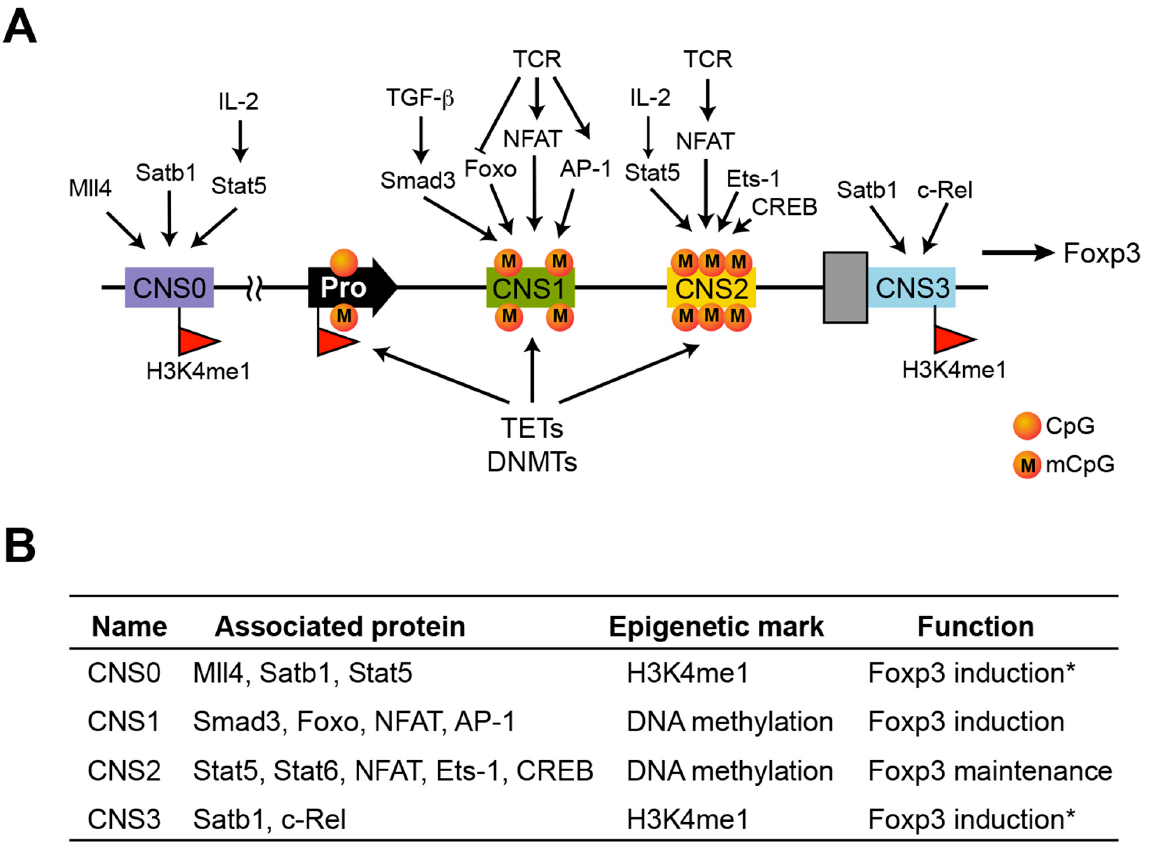
Figure 1. Cis -regulatory elements controlling Foxp3 expression. ( A ) Schematic of the cis -regulatory elements of the Foxp3 gene. Representative binding proteins and their upstream pathways are shown. CNS0 is localized in an intron of upstream gene Ppp1r3f (not shown). Pro, promoter. ( B ) Summary of Foxp3 enhancers and their representative binding proteins, epigenetic modifications, and roles in Foxp3 expression. * CNS0 and CNS3 were recently shown to play a role in maintaining Foxp3 expression in the absence of CNS2 or CNS0, respectively